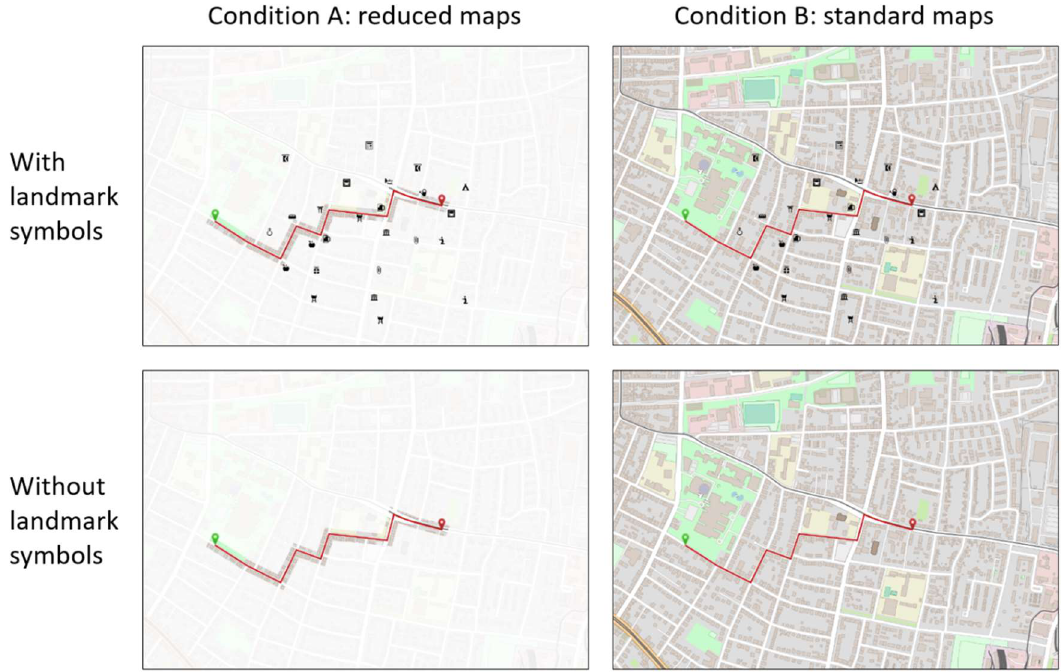
Figure 1. Study map conditions and variants. According to their experimental condition, participants saw either six reduced or six standard study maps. Participants from both conditions saw three maps with landmark pictograms and three maps without landmark pictograms.